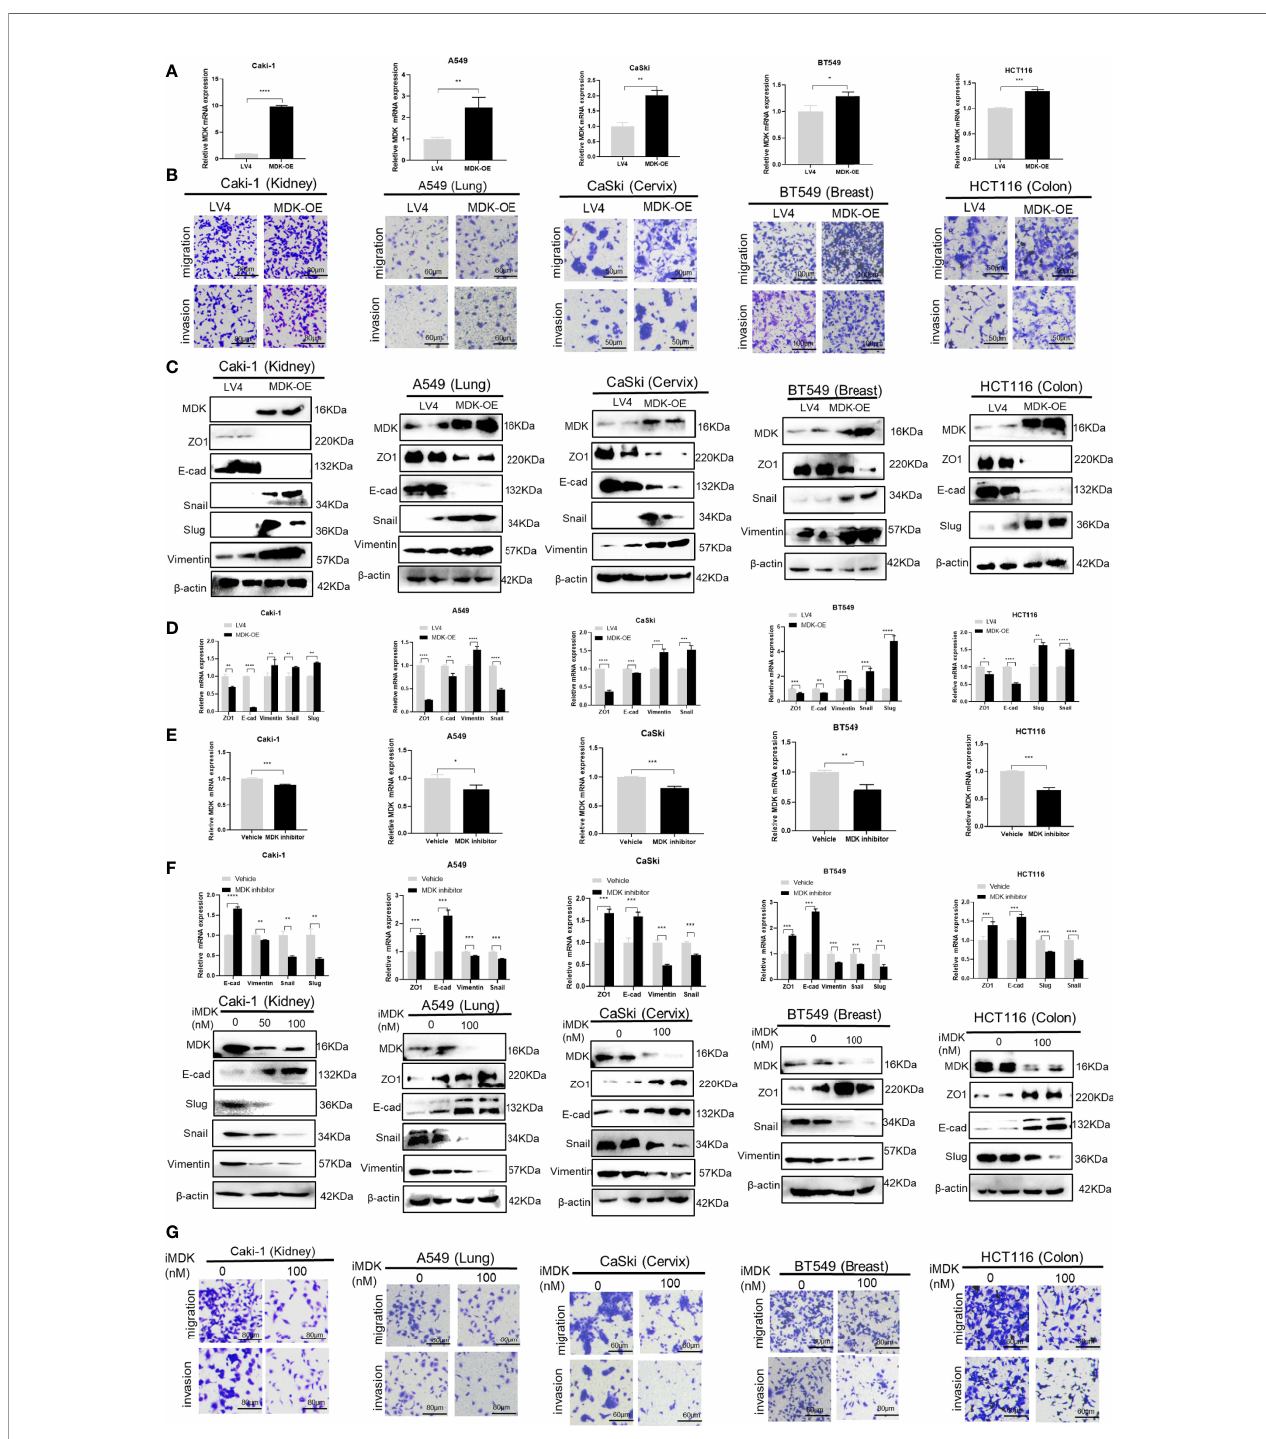
FIGURE 5 | MDK promotes cancer metastasis by activating the EMT programme. (A) RT-qPCR validation of MDK overexpression in fi ve cancer cell lines. (B) Transwell assays to assess the alteration of cell invasion and migration abilities by MDK overexpression in fi ve cancer cell lines. (C) Western blotting assays to assess the effect of MDK overexpression on expression of EMT markers. (D) RT-qPCR assays to assess the effect of MDK overexpression on expression of EMT markers. (E) RT-qPCR validation of MDK inhibition by iMDK (100nM, 48h). (F) RT-qPCR and Western blotting assays to assess the effect of iMDK on EMT in fi ve cancer cell lines. (G) Transwell assays to assess the effect of iMDK on cell invasion and migration in fi ve cancer cell lines. Data are shown as the mean ± standard deviation (SD). *P < 0.05, **P < 0.01, ***P < 0.001, ****P <